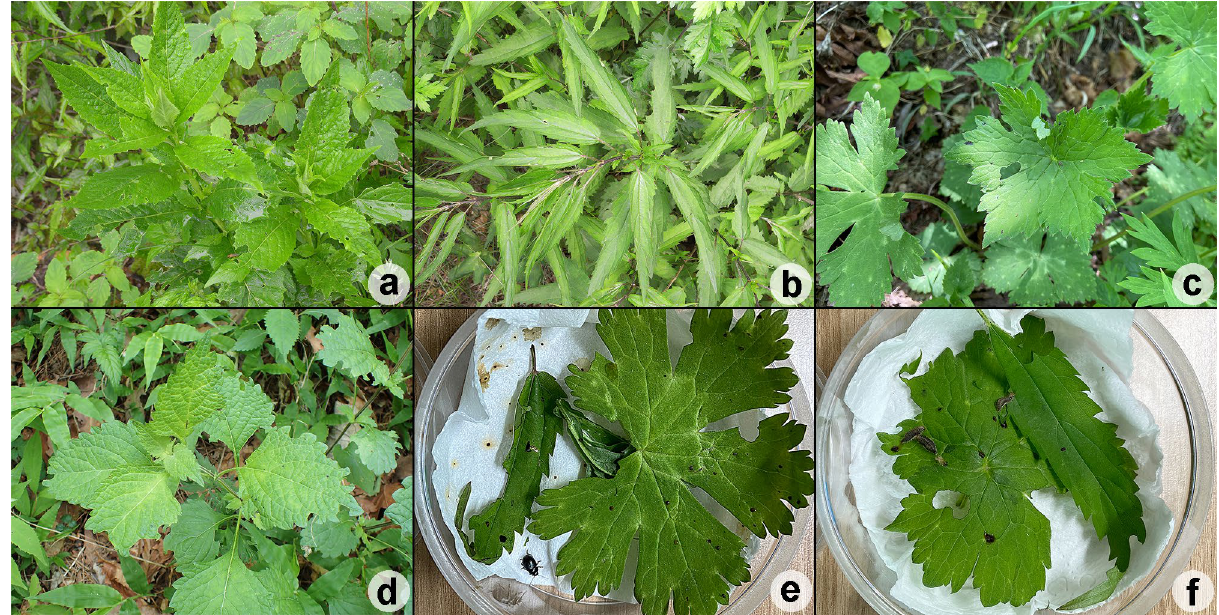
Figure 6. Host plants of Suinzona borowieci sp. nov.: (a) Arabis pendula L. from Yeongyang, (b) Urtica angustifolia Fisch. ex Hornem. from Yeongyang, (c) Aconitum pseudolaeve Nakai from Taebaek, (d) Isodon inflexus (Thunb.) Kudo from Yecheon; (e–f) A . pseudolaeve Nakai and U . angustifolia Fisch. ex Hornem. for laboratory tests (e) Adult from Yeongyang feeding on leaves, (f) larvae from Yecheon feeding on